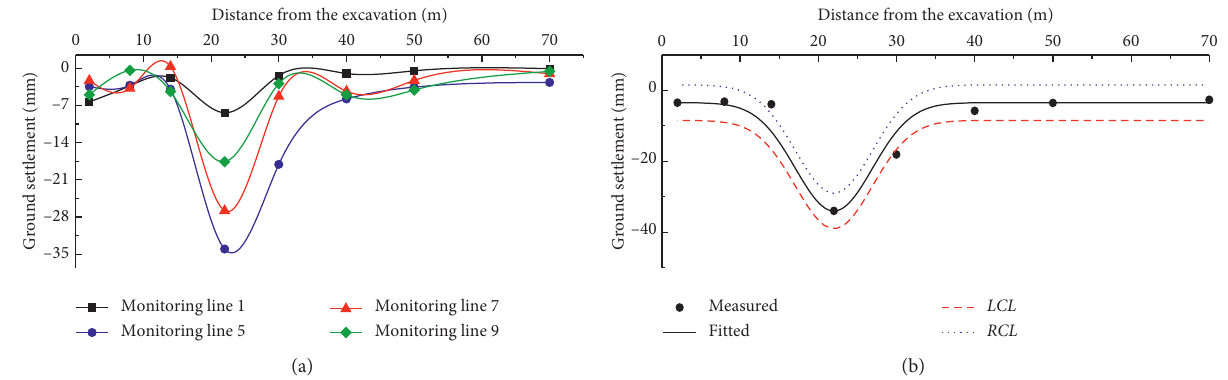
Figure 6: Ground settlement varying with (a) different settlement monitoring points and (b) control lines.